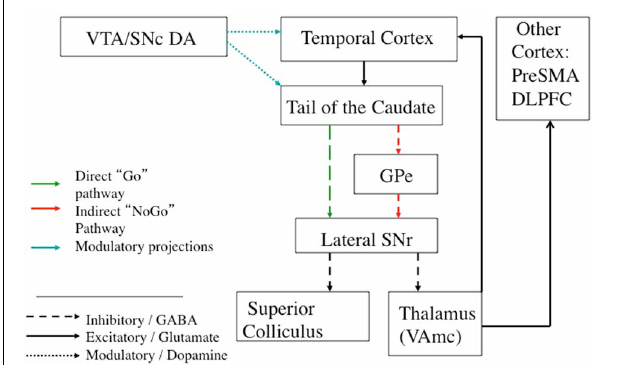
FIGURE 5 | Schematic diagram of the visual corticostriatal loop, including the best established open and closed loop connections. Broad regions of extrastriate and visual temporal cortex project to the tail of the caudate. From the tail of the caudate, direct pathway projections go to the lateral SNr. There are open loop projections from SNr to superior colliculus that can directly release eye movements. There are also projections to the thalamus. From thalamus, there are projections back to cortex that close the loop, as well as open loop projections to other cortical regions, such as the pre-SMA. The hyperdirect pathway is not included because it is unknown if visual cortex projects to STN; see text for details. GPe: Globus Pallidus, external portion. Pre-SMA: Pre supplementary motor area. DLPFC: Dorsolateral Prefrontal Cortex. SNr: Substantia Nigra pars reticulata. VTA: Ventral Tegmental Area. SNc: Substantia Nigra pars